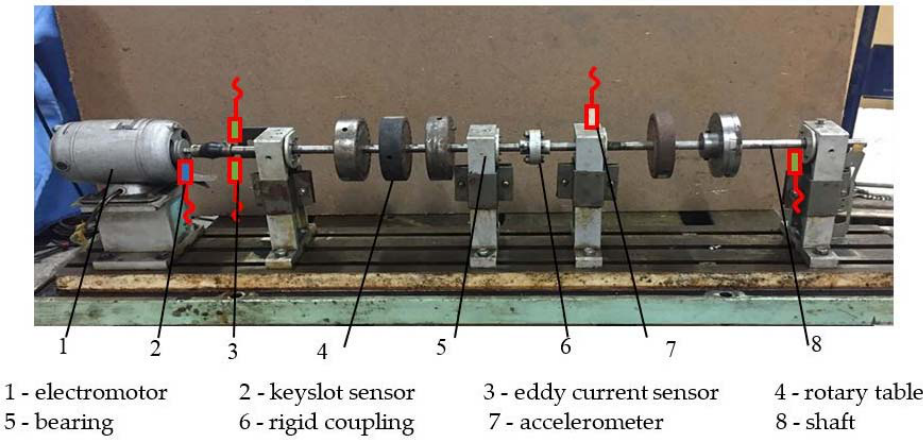
Figure 7. Structure of the rotor testbed.